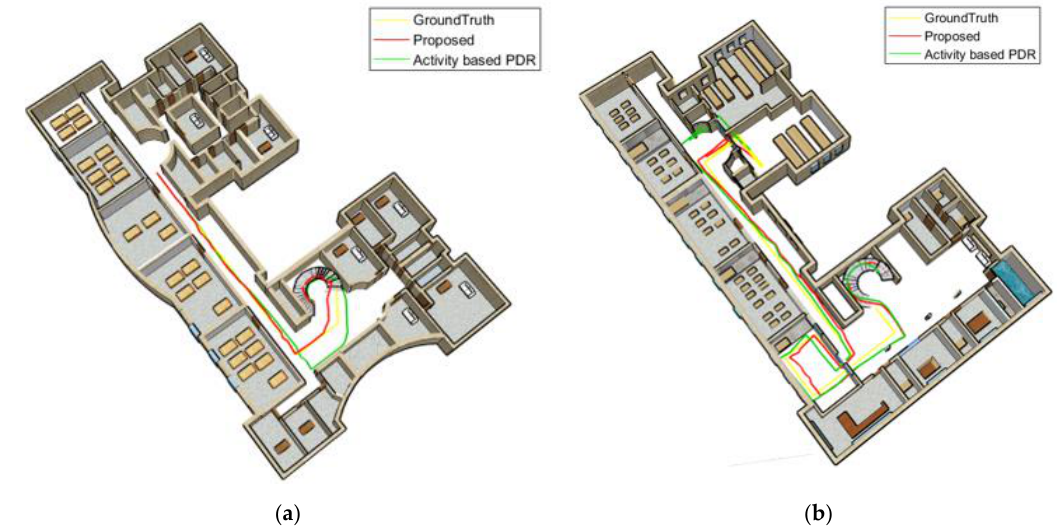
Figure 25. Swinging man; ( a ) third floor; ( b ) first floor.